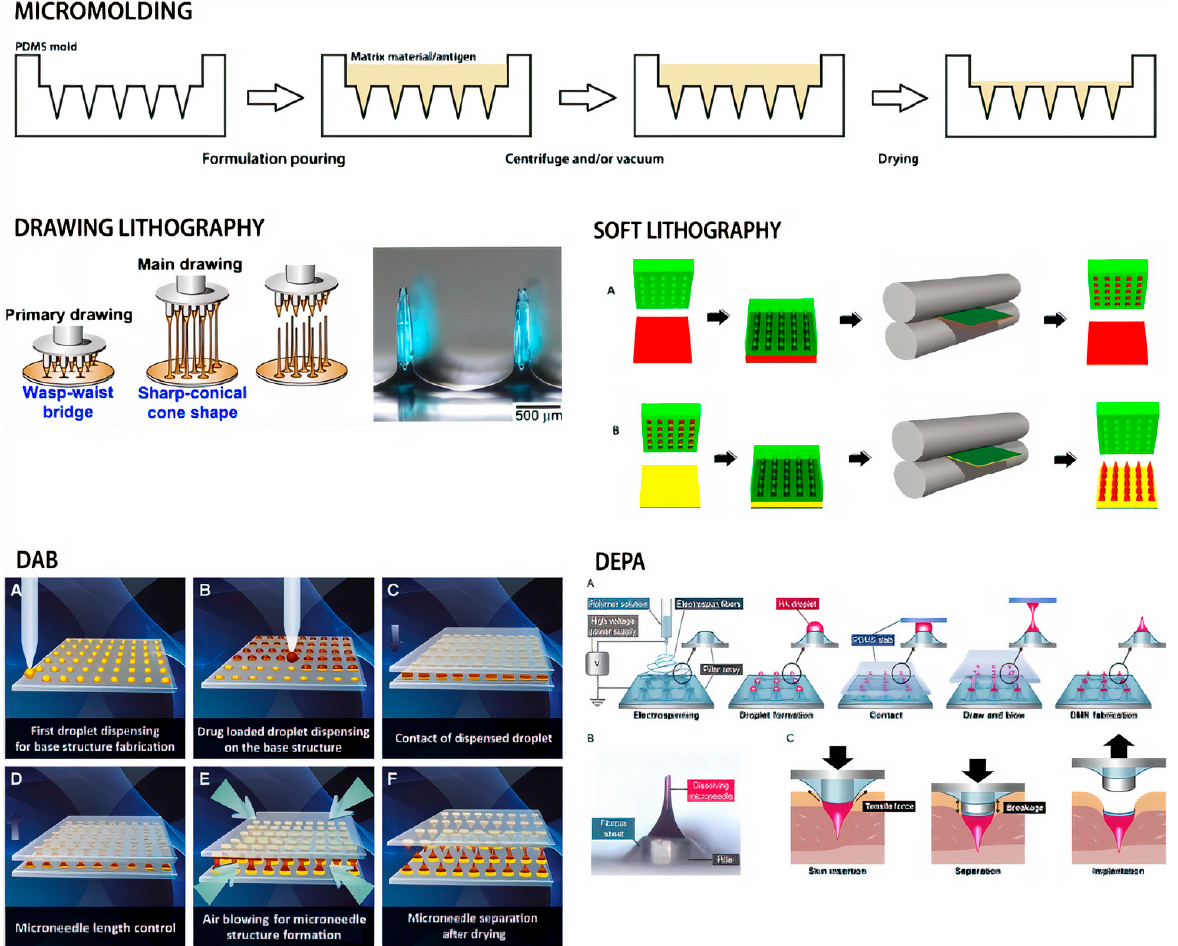
Figure 5. dMN manufacturing methods (taken from [277]) Micromolding with a polydimethylsilox- ane (PDMS) mold is the most prevalent method for producing dMNs. Drawing lithography oper- ates by extending two-dimensional polymeric material into a three-dimensional shape. Longitudi- nal extension of molten polymer by pillaring higher moving plate. In soft lithography , dMNs are produced by (A) heating a polymer sheet and a mold with microcavities. (B) The filled mold is then heated and placed on a flexible, water-soluble substrate. After mold detachment, a dMN patch re- mains on the substrate. Droplet-born air blowing (DAB) applies a (A) polymer solution and (B) a drug solution to two plates. (C) The upper plate is lowered until the droplets meet, (D)then with- drawn a distance equal to the two dMN lengths of the lower and top plates. (E) Drying the polymer solutions results in a dMN patch on each plate. (F) In addition, fabrication at moderate temperatures (4–25 degrees Celsius) minimizes medication and polymer waste. dMN on an electrospun pillar array (DEPA) is a variant of DAB. (A) The flat plate is replaced with a columnar array covered in a fibrous layer. (B) A PDMS slab is then utilized to draw and stretch polymer formulation droplets, resulting in microneedles. (C) Finally, the movement of air dries off the elongated droplets to form dissolving microneedles.